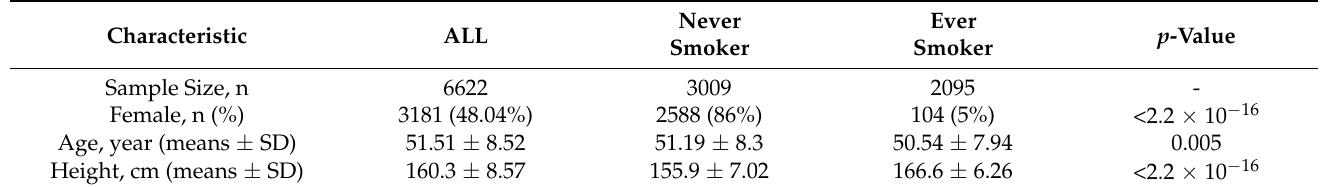
Table 1. Descriptive characteristics of study participants with more than three follow-up